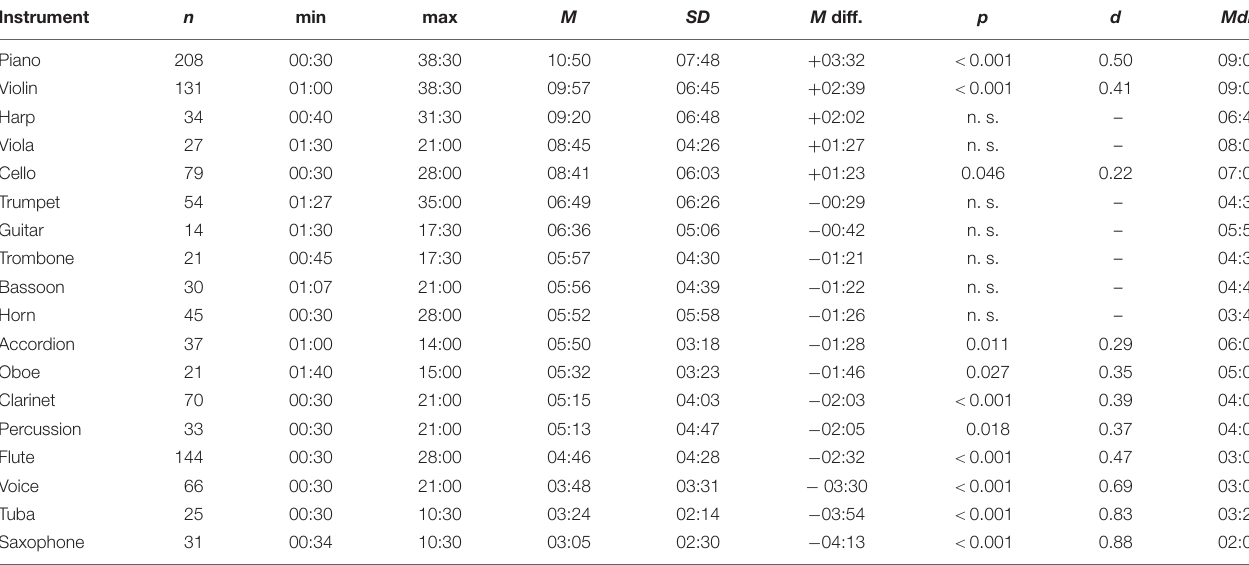
The table gives an overview of practice time in hours per week for different instruments: number of cases (n), minimum (min), maximum (max), mean (M), standard deviation (SD), difference of the instrument-specific mean (M diff.) from the general mean of the weekly practice time in the subsample of all instruments represented here (M = 07:18; SD = 6:18; n = 1,070), significance of these differences (p; t-test in single sample), effect size (Cohen’s d) and median (Mdn).